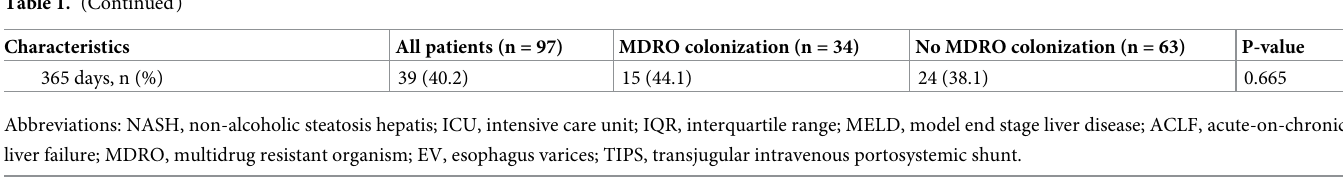
PLOS ONE | https://doi.org/10.1371/journal.pone.0268638 May 24,